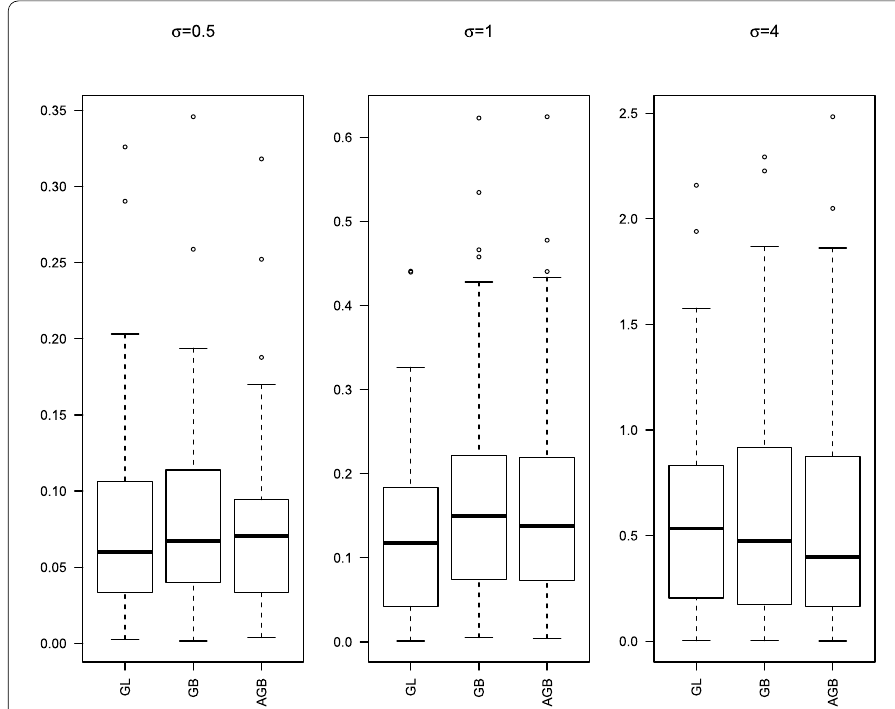
Figure 3 Boxplots of L 2 loss for p n =